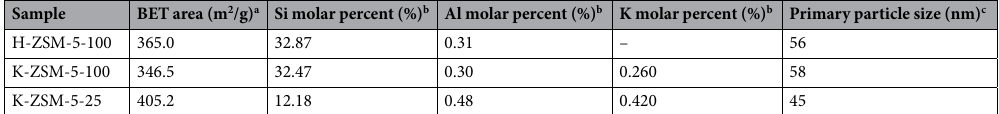
Table 1. Physicochemical properties of the samples. a Determined from the N 2 adsorption/desorption isotherms; b Determined from the ICP–AES analysis; c Calculated using Scherrer